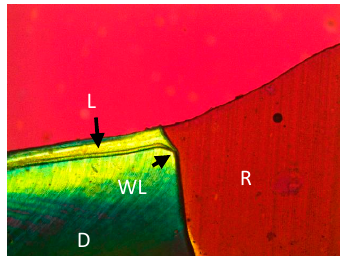
Figure 1. Z100 restoration in dentin at 10 times magnification (R—restoration, D—dentin, L—lesion, WL—wall lesion).